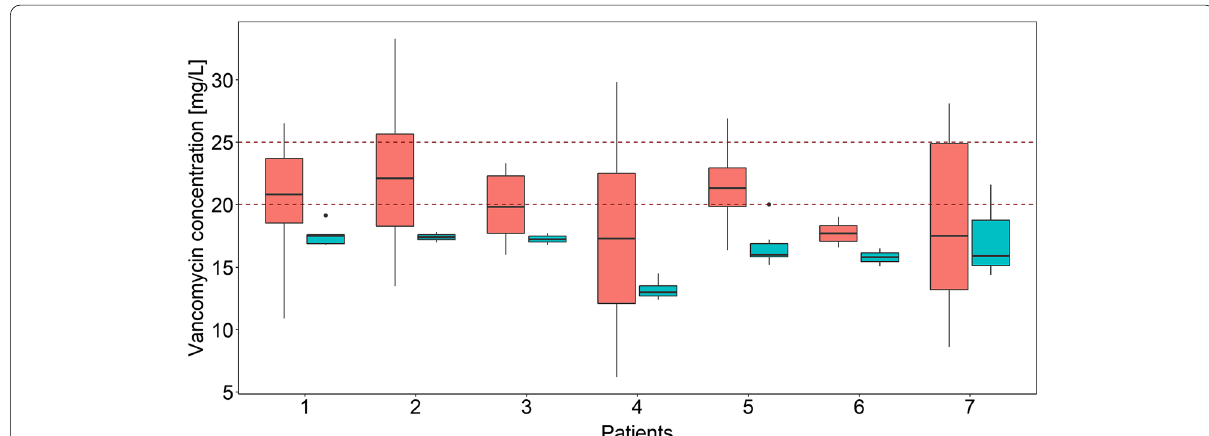
Fig. 1 Boxplot of vancomycin concentration during (turquoise) and without (red) CytoSorb ® therapy across patients. Lower and upper box boundaries 25th and 75th percentiles, respectively; line inside box: median; lower and upper error lines: 10th and 90th percentiles, respectively; points: data falling outside 10th and 90th percentiles; dashed red line: target concentration for vancomycin